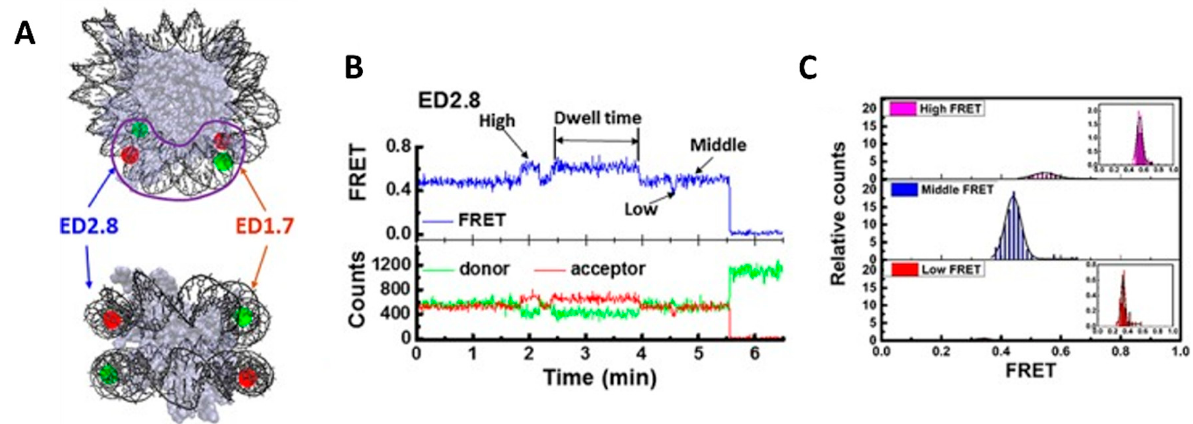
Figure 3. ( A ) A labeling scheme to study the conformational dynamics of the nucleosome. While in the native state, the FRET efficiency is expected to be high, whereas in the loosened state, the FRET efficiency decreases owing to the increased distance between two gyres of DNA. ( B ) A representative FRET trace showing nucleosome dynamics. The green, red and blue lines represent donor intensity, acceptor intensity and FRET efficiency, respectively. The trace shows the transition of nucleosomes between three conformational states corresponding to the high, mid, and low FRET states observed therein. The rate of transition from one state to another can be calculated from the dwell time of each state. ( C ) The FRET efficiency histograms calculated from the FRET traces (top: high; middle: mid; bottom: low). The area under the curve gives the population of the corresponding FRET state. Evidently, in this case, the mid FRET state is the most populated one. The peak positions denote the FRET efficiency of the maximum number of molecules. Within the scope of the measurement, the authors could not assign any specific FRET state to the native structure. However, by using varied labeling positions, they could conclude that the FRET states represent conformations generated by the gaping motion of the DNA perpendicular to the nucleosome plane. The figures have been adapted from [47] with permission.